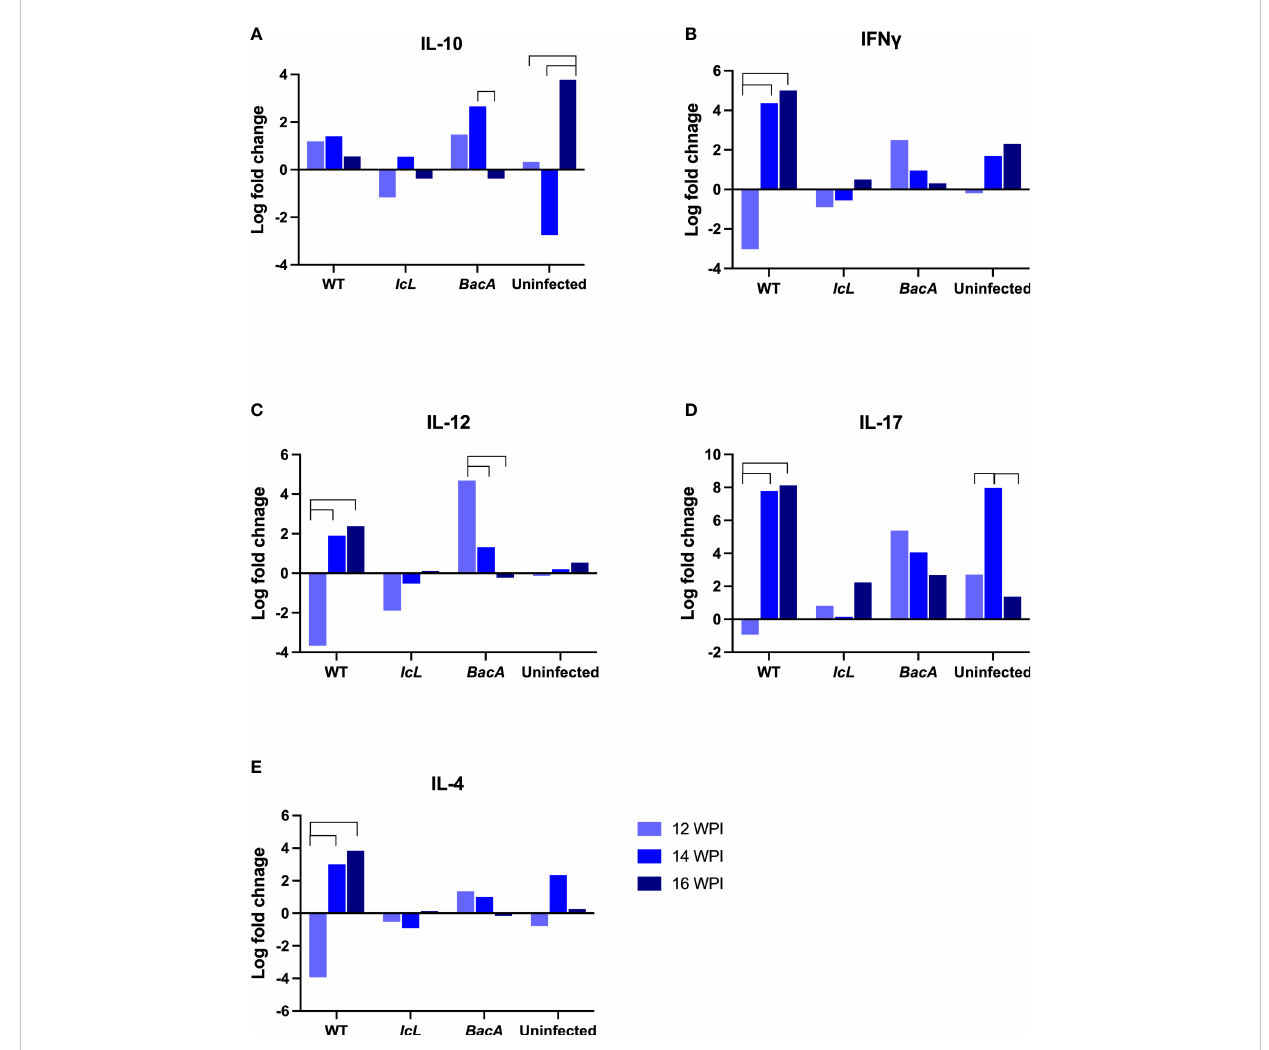
FIGURE 6 Cytokine expression within each group after stimulation of PBMCs with PPDa at 12-, 14-, and 16-weeks post inoculation. The difference among groups were assessed by one-way ANOVA and then further validated by Tukey-Kramer